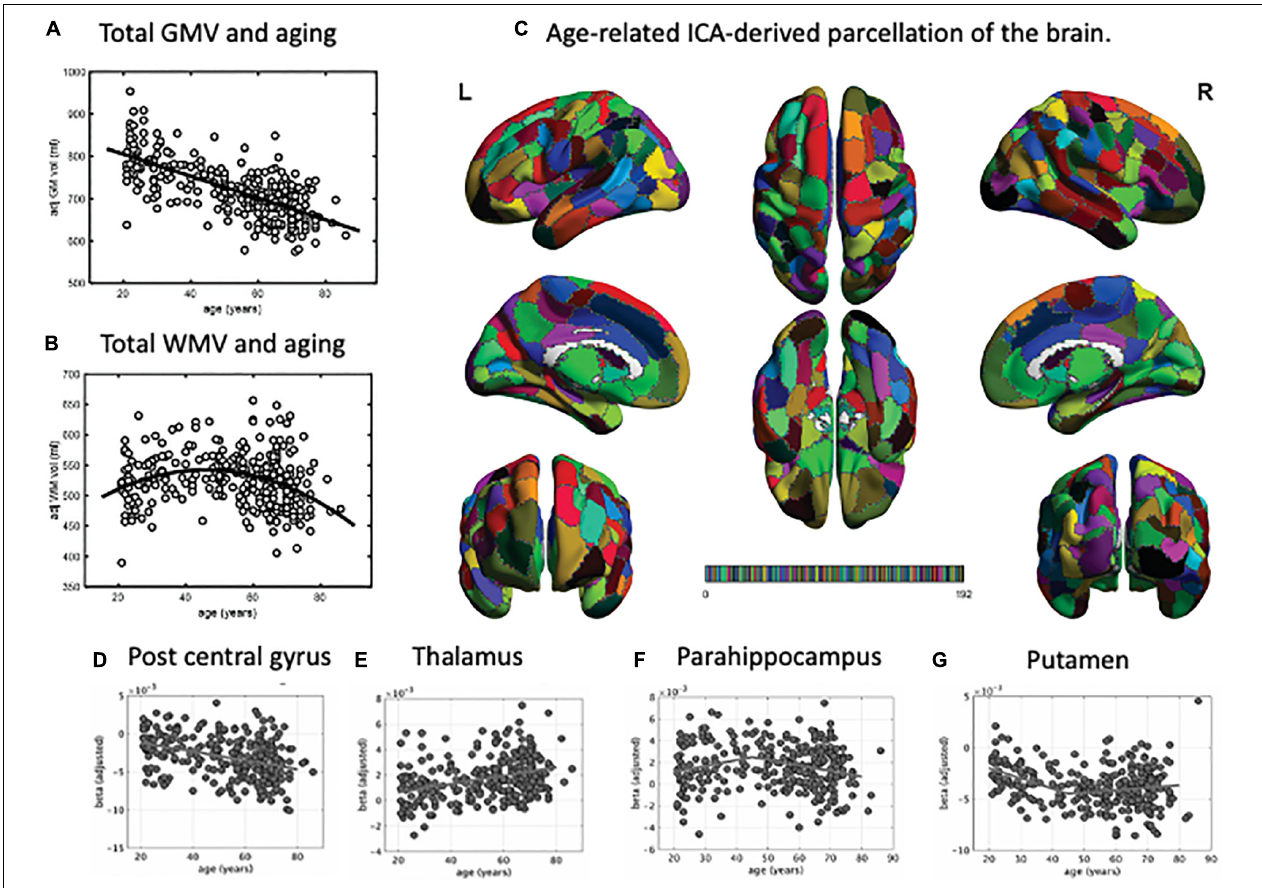
FIGURE 1 | Parcellation map for the unbiased, data-driven, age-related brain structure. Total gray matter volume decreased with aging (A) . However, the total white matter volume peaked at around 50 years of age, followed by a decrease (B) . Using independent component analysis, we extracted 192 brain regions related to aging (C) . Based on this parcellation map, we identified regions where brain volume decreased with age (e.g., post central gyrus, D ), remained stable (e.g., thalamus, E ), or peaked at around 45 years of age and then decreased (e.g., parahippocampus, F , and putamen, G ). GMV, gray matter volume; WMV, white matter volume; ICA, independent component analysis. This figure is adapted from Bagarinao et al.